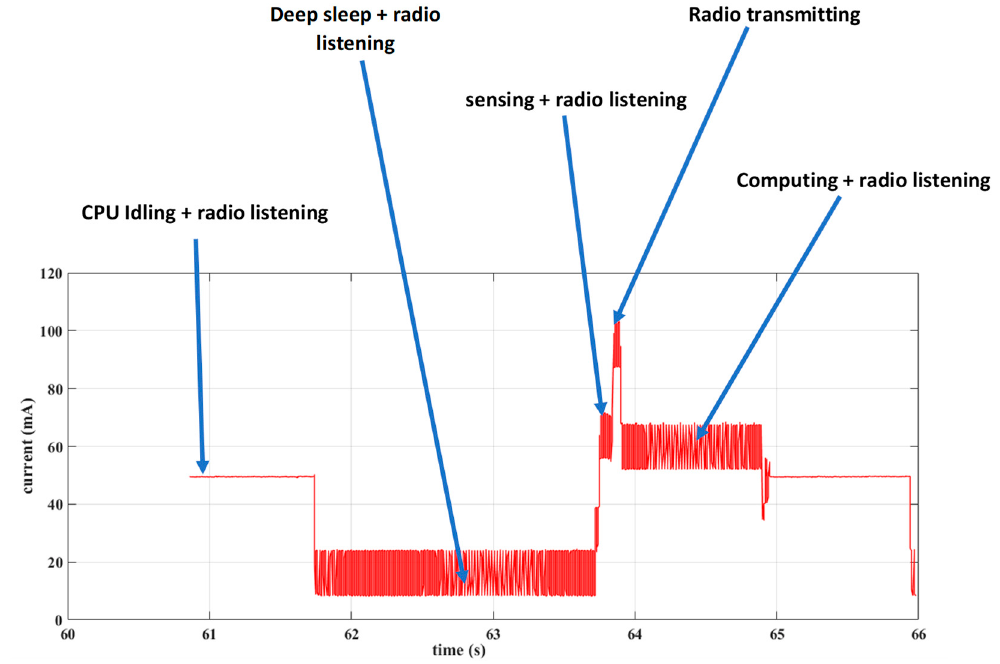
Figure 15. Sensor’s node current profile with deep sleep implemented.